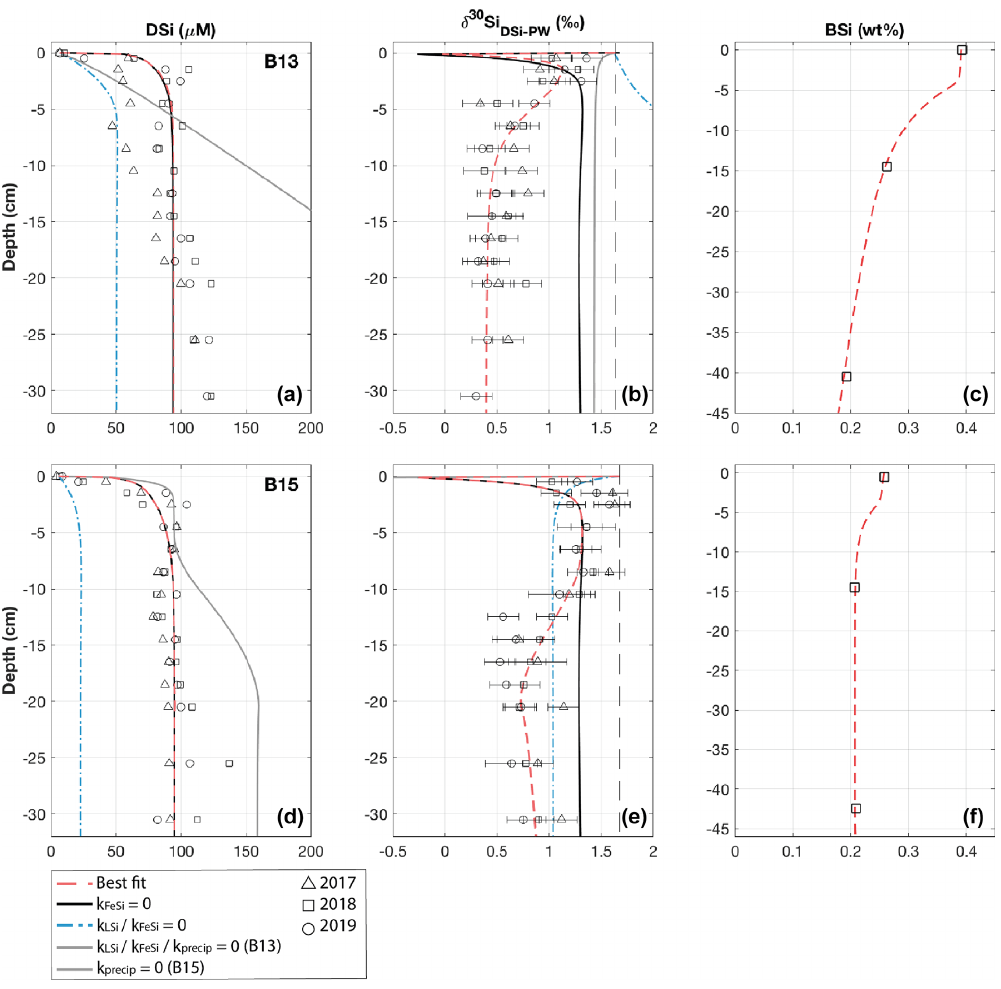
Figure 3. Dashed red lines show best-fit steady state model simulations for stations B13 (a, b, c) and B15 (d, e, f) (see Fig. S2 for station B14), which require BSi and LSi dissolution, AuSi precipitation, and FeSi desorption (see Table S2 for all boundary conditions). Additional simulations are based on a series of sensitivity experiments carried out to assess the importance of each reaction pathway. Left to right: sediment pore water DSi concentration, sediment pore water DSi δ 30 Si, solid-phase BSi content. Vertical dashed black lines represent the core top water δ 30 Si from 2017; open shapes show observational pore water data (Ward et al., 2022). Error bars on δ 30 Si data are based on long-term reproducibility, derived from repeat measurements of the diatomite standard (2 σ ± 0.14, n = 116), unless the error derived from analytical replicates was